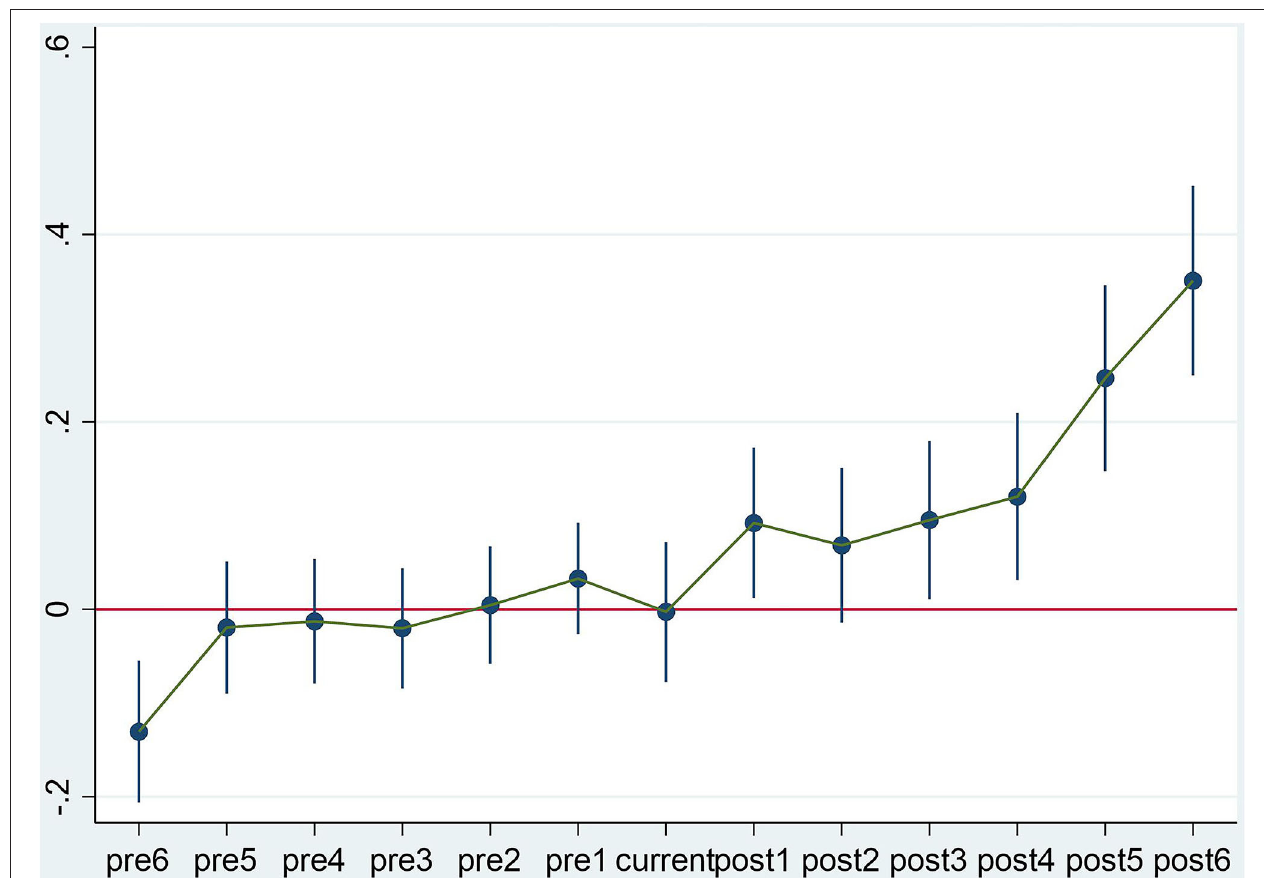
FIGURE 2 | Parallel trend and dynamic change of bed resource